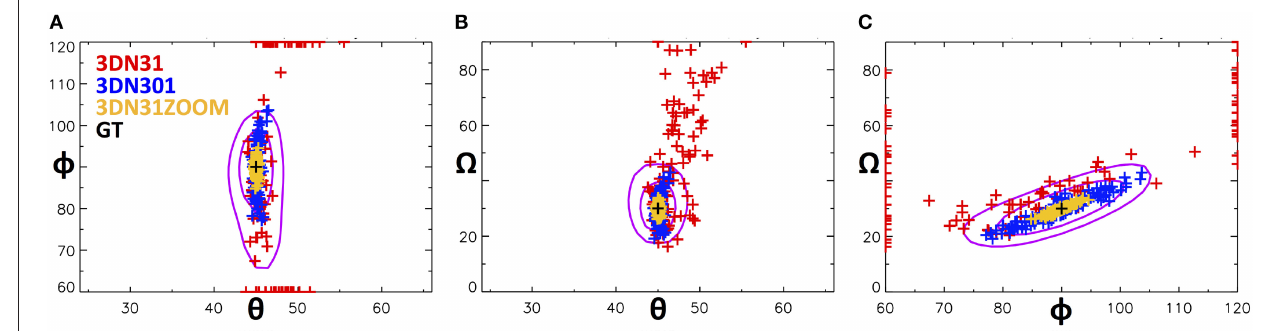
FIGURE 4 | 2D scatter plots of the maximum likelihood estimators (MLEs) found for each design of the 3DN31 (red crosses), 3DN301 (blue crosses), and 3DN31ZOOM (yellow crosses) cases. The black cross highlights the position of the exact maximum (i.e., ground-truth). The two purple solid lines show [0.9 ; 0.95] × max ( ℓ ) isocontours. Note that, in panel (B) , the red crosses (MLEs of 3DN31) outside the two log-likelihood function isocontours are the solutions associated with φ MLEs = 60 ◦ and φ MLEs = 120 ◦ from panels (A,C) .